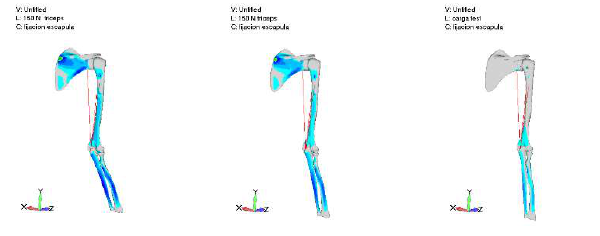
Figure 12. Different elbow angle configuration: bone Von Mises stress distribution under triceps loading (150 N on wrist) cases. Figures are included in more quality in Appendix A.